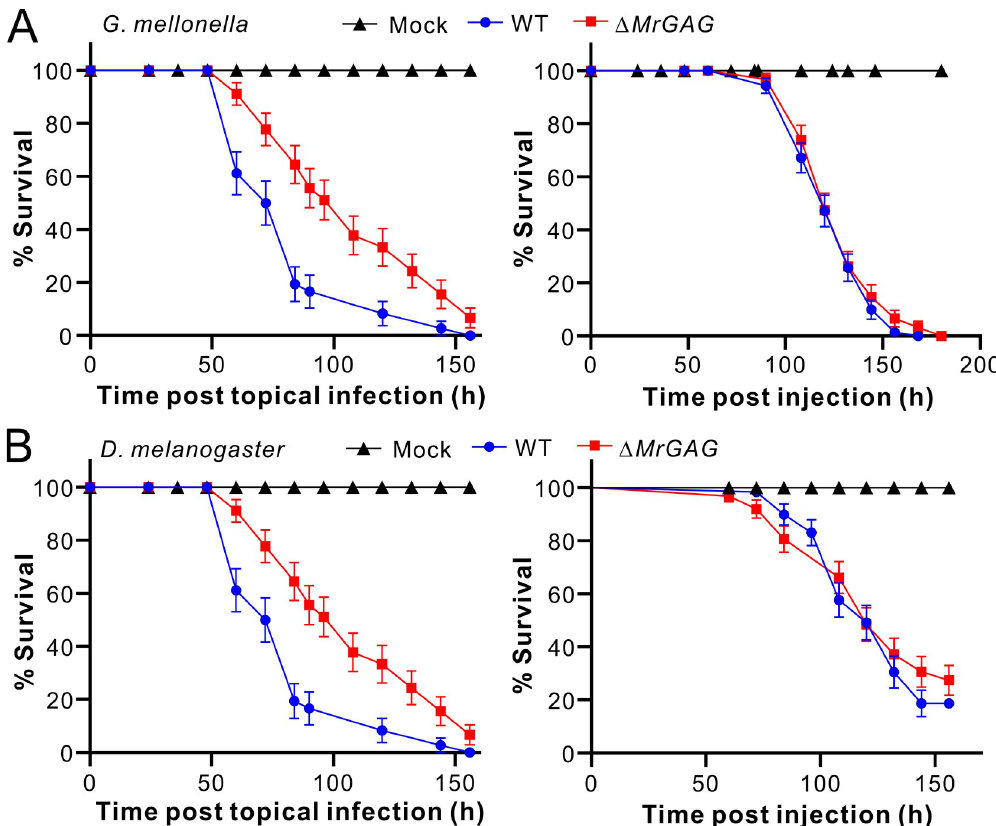
Fig 4. Insect survivals after infections by WT and Δ MrGAG . (A) Topical infection (left panel) and injection (right panel) assays against the last instar larvae of wax moth G . mellonella . (B) Topical infection (left panel) and injection (right panel) assays against the female adults of the fruit fly D . melanogaster . Insects treated with 0.05% Tween-20 were used as a mock